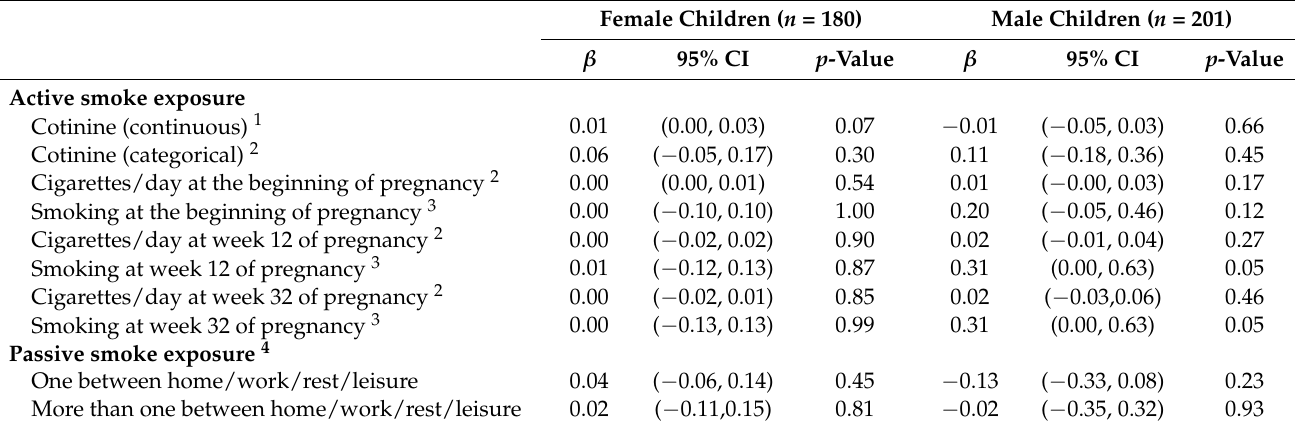
Table 2. Association between prenatal exposure to tobacco and anogenital index in 4-year-old